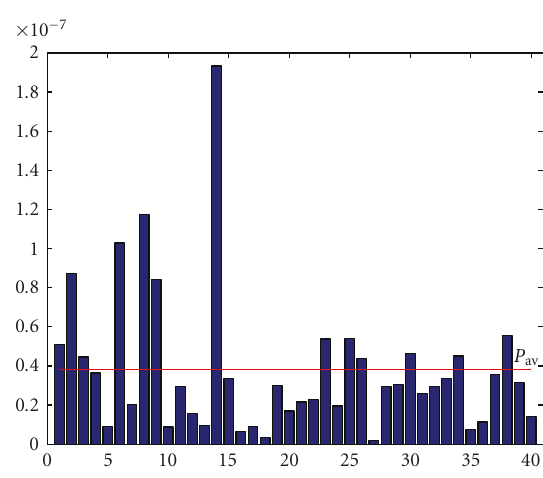
Figure 5: Total transmission power.